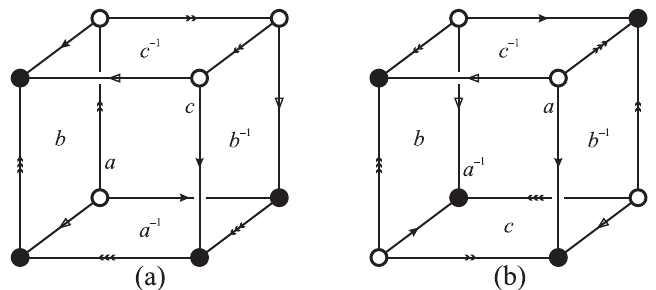
Figure 8. The two face identifications of the cube determining fixed point free spherical tilings. The generated groups are G